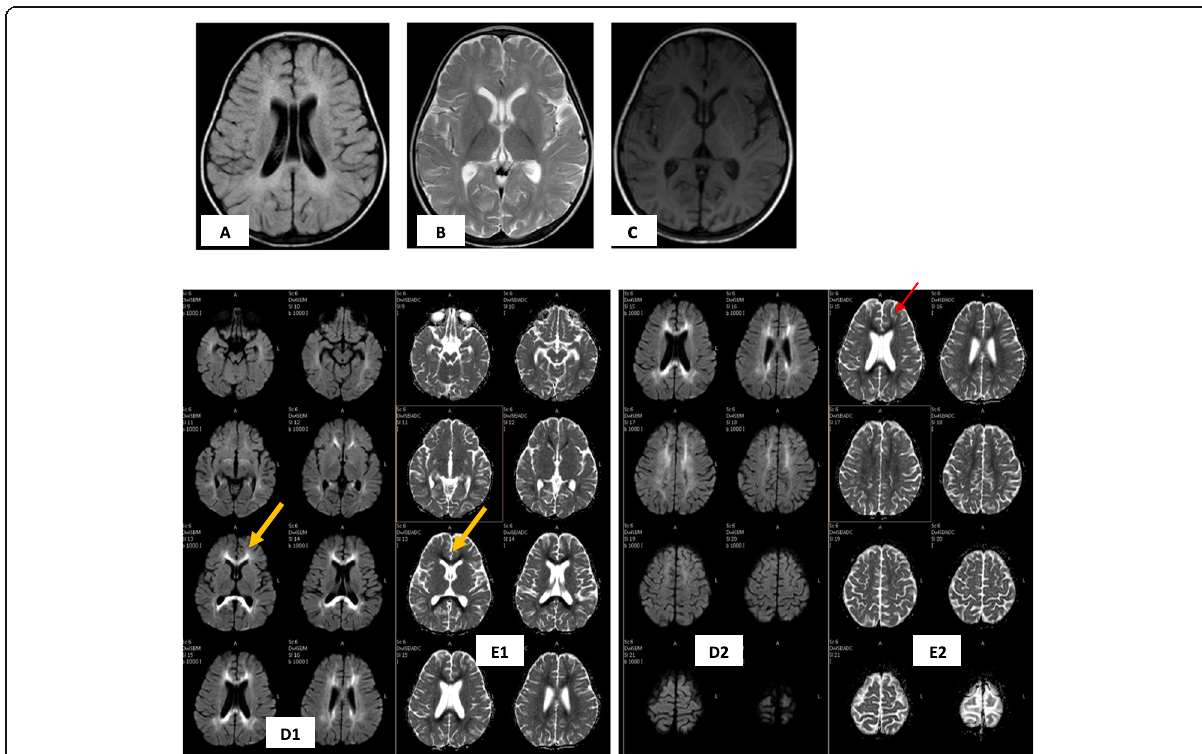
Fig. 3 19-month-old boy with infantile form metachromatic leukodystrophy , positive family history of children death at the age of 20 months. Different sequences MRI revealed bilateral symmetrical areas of high T2 and FLAIR signal in the periventricular white matter with sparing of the subcortical U fibers (red arrow in E2 ) and extension into the corpus callosum (yellow arrow in D1